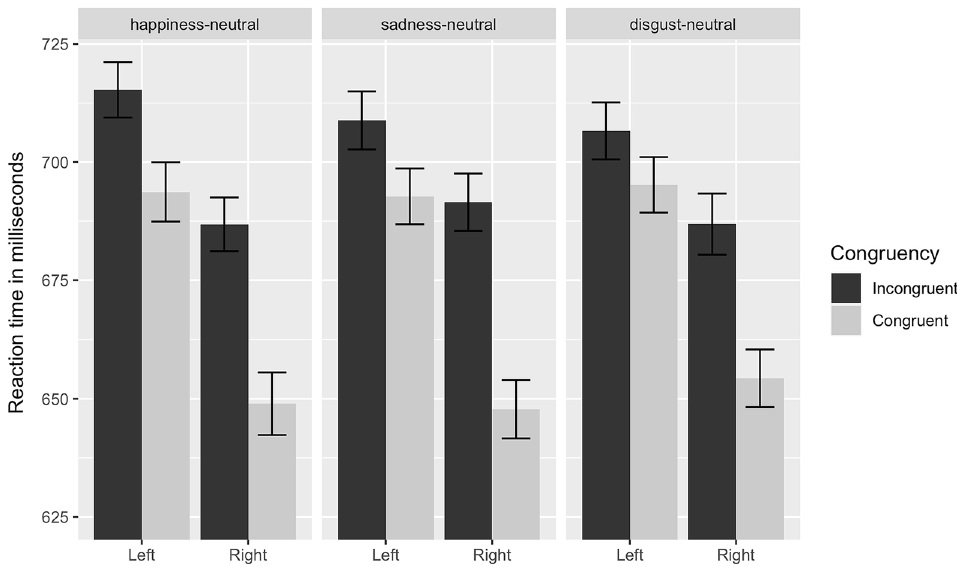
Figure 1. Reaction times in ms for happy-, sad-, and disgusted-neutral facial expression pairs as a function of congruency and location (i.e., (bottom) left, or (top) right position of the emotional facial expression). Error bars denote standard error.